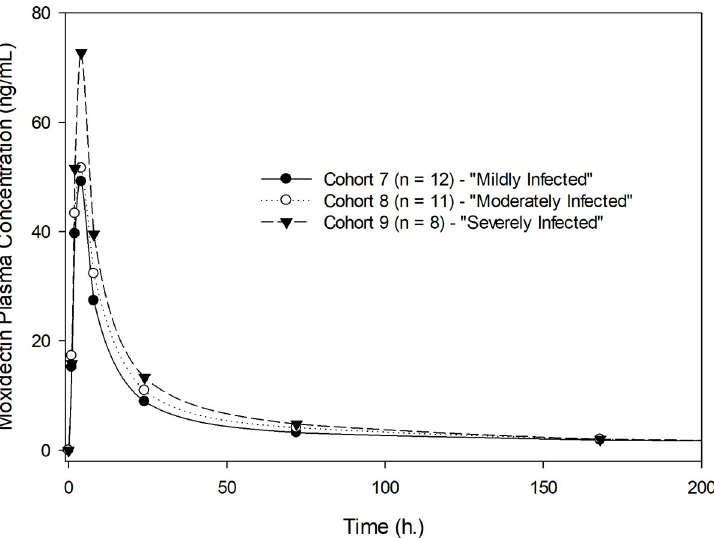
Fig 4. Plasma concentrations of moxidectin after single oral administration of 8 mg by severity of infection, displayed as geometric means.